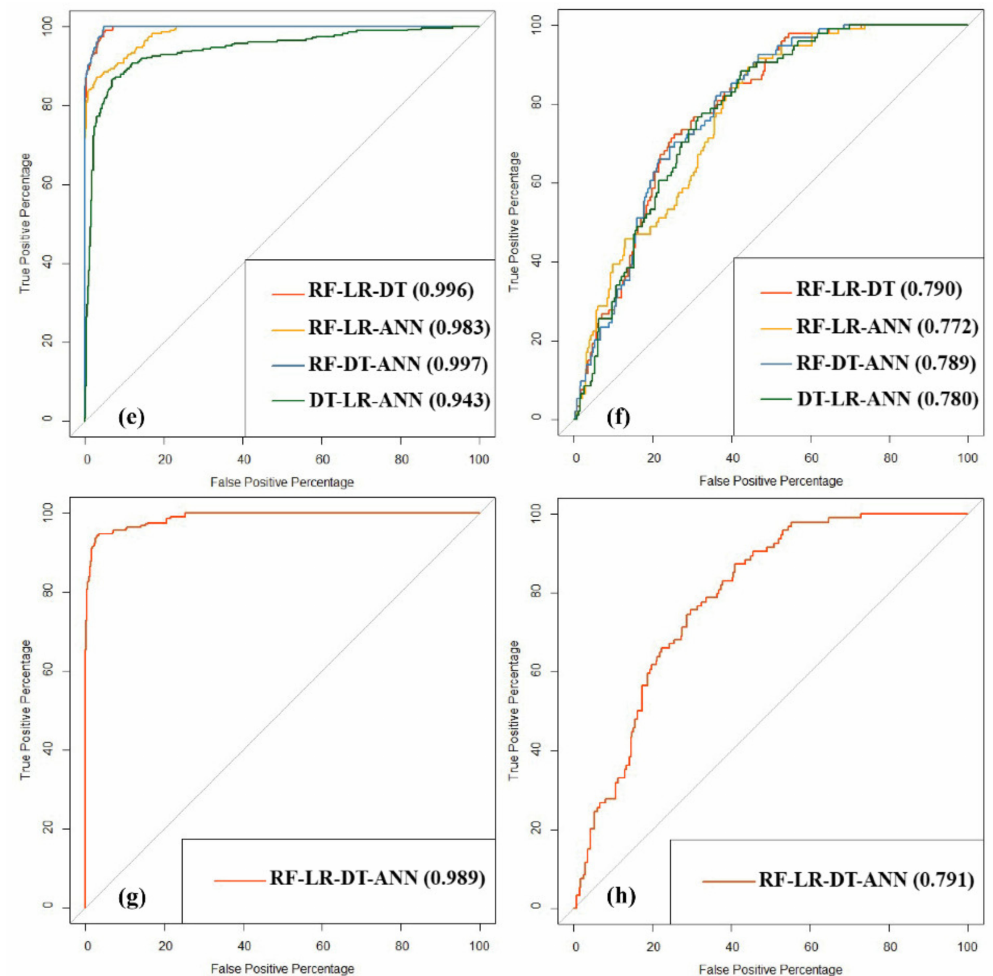
Figure 9. ROC curve: ( a ) success rate of individual models, ( b ) prediction rate of individual models, ( c ) success rate of ensemble of two models, ( d ) prediction rate of ensemble of two models, ( e ) success rate of ensemble of three models, ( f ) prediction rate of ensemble of three models, ( g ) success rate of ensemble of four models and ( h ) prediction rate of ensemble of four